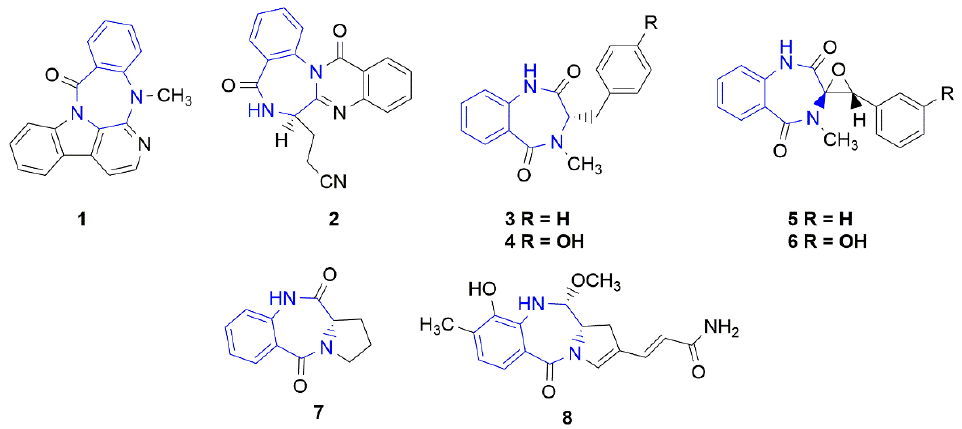
Figure 1. Benzodiazepine derivatives isolated from natural sources. The benzodiazepine core is marked in blue.